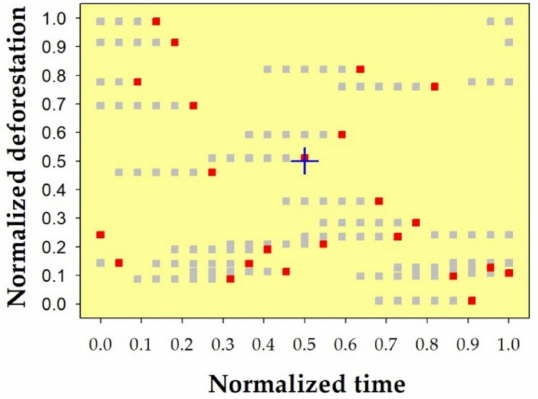
Figure 19. Normalized hypothetical time-series data as shown in Figure 7. Red squares indicate the origin; grey squares indicate left shifts from the origin, representing an acceleration of detection from 16 days to 80 days. The blue cross is the centroid of the graph.